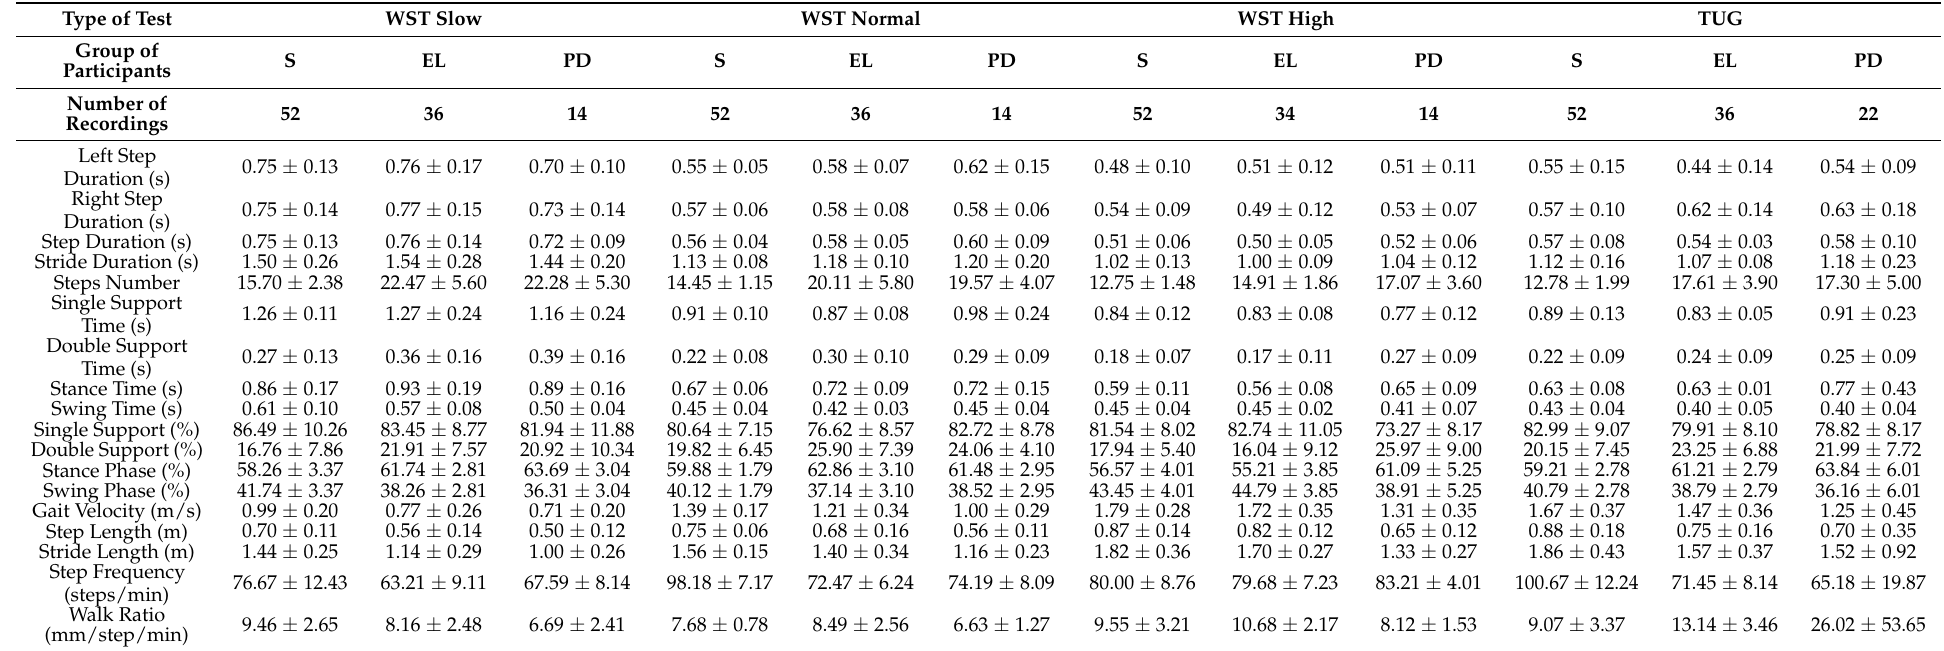
Table 6. Results on Straight Lines (Mean values along with Standard Deviations) of temporal and spatial characteristics using the Smart-Insole